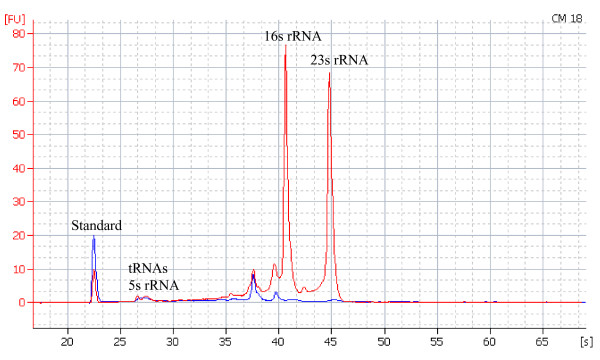
Removal of 16s and 23s rRNAs using MICROB Express™ kit from Ambion. Total RNA samples before (in red) and after (in blue) rRNA depletion were analyzed on the Agilent 2100 Bioanalyzer.